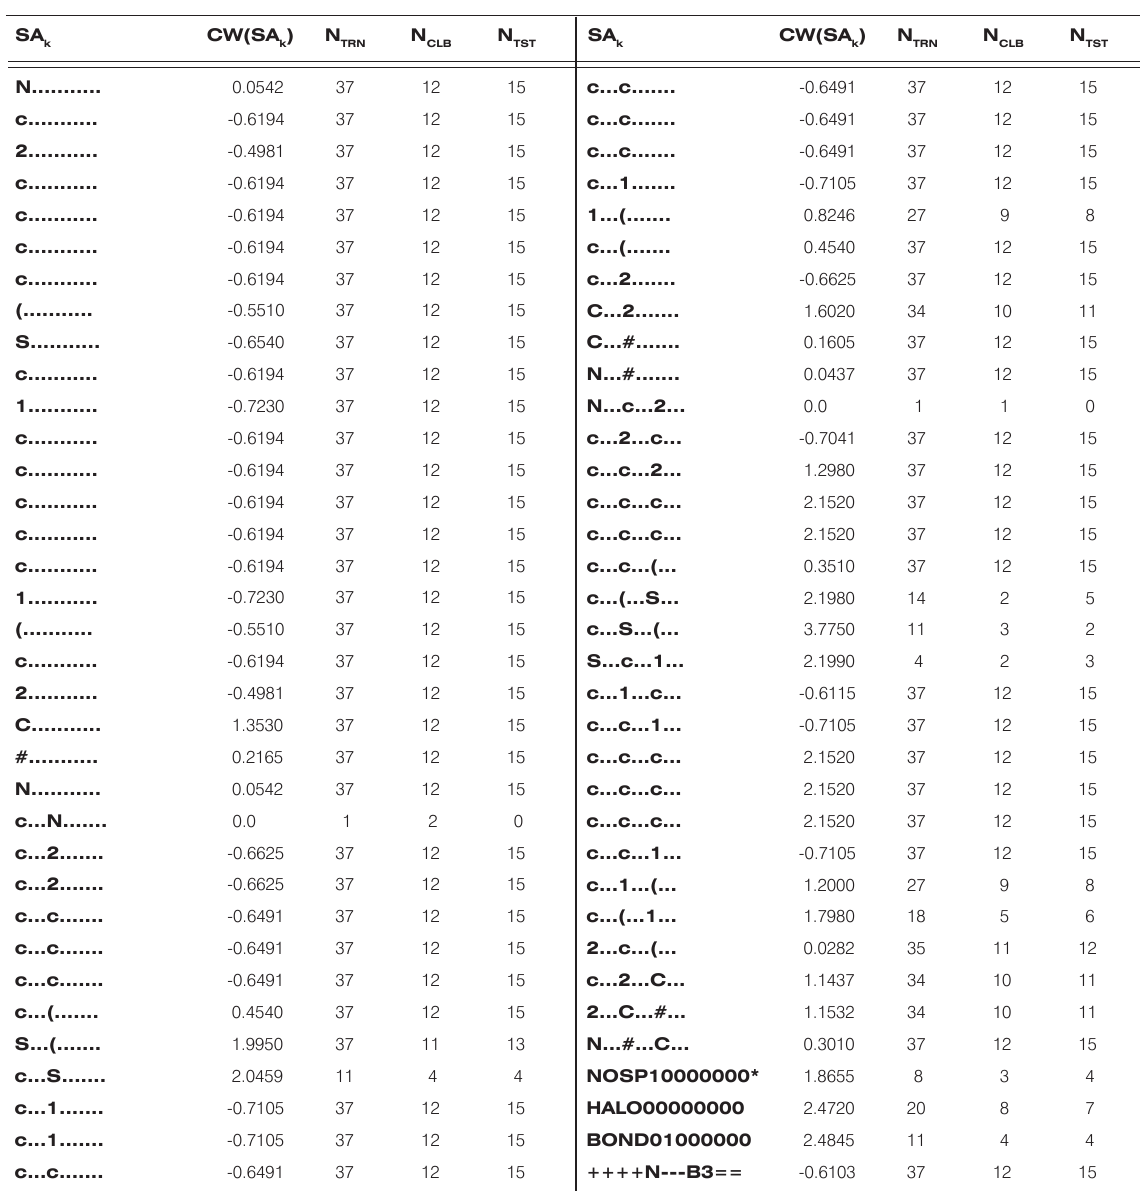
) calculation: SET 1, split epoch